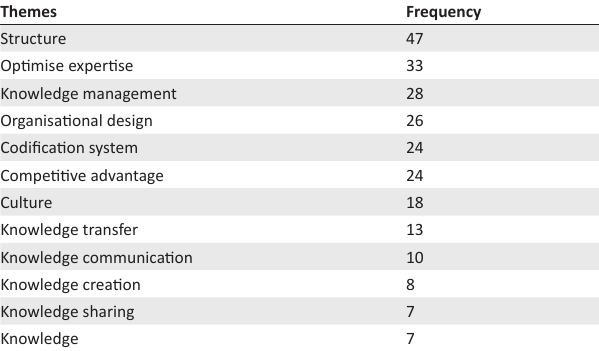
TABLE 2: Themes deduced from the